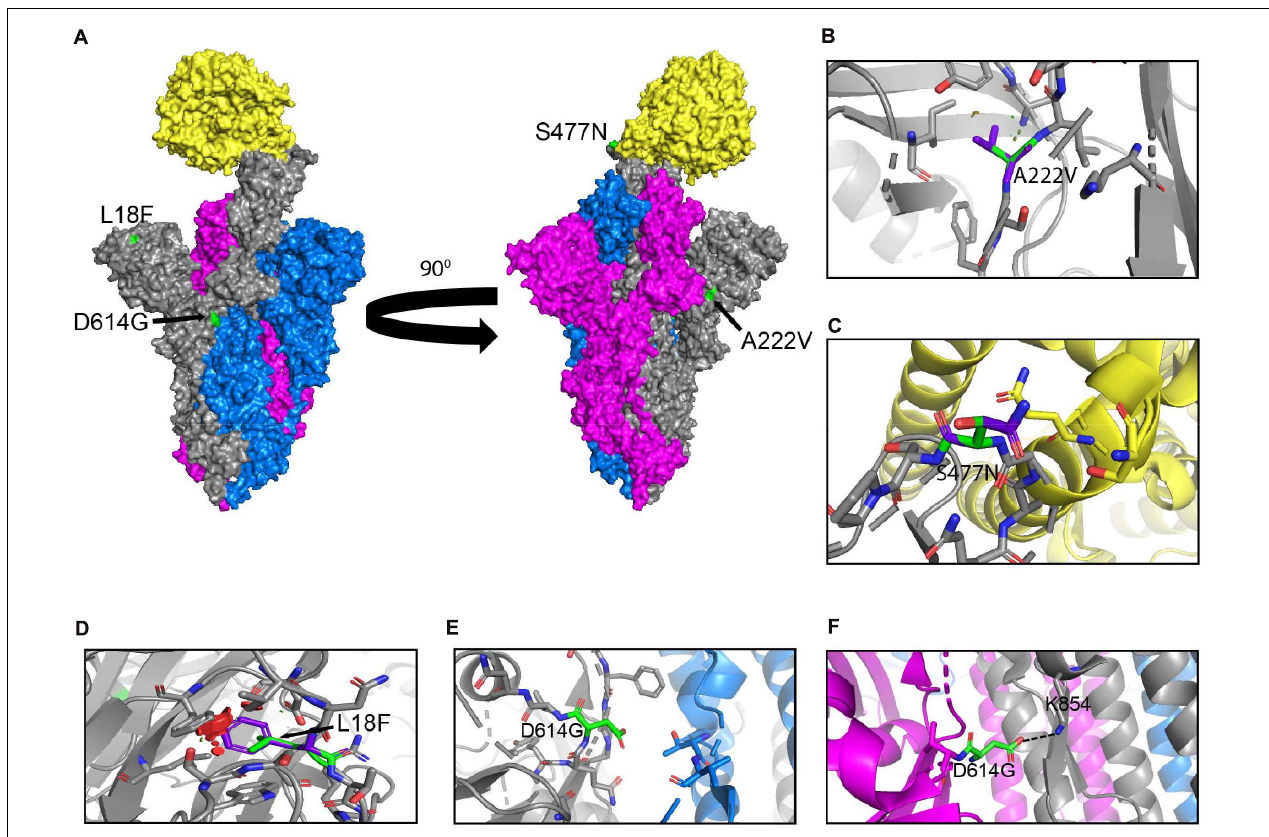
FIGURE 3 | Structural rendering of the most frequent mutations in the S protein. (A) Surface representation of human angiotensin-converting enzyme 2 (hACE2) (yellow) in complex with S protein trimers illustrated in gray, blue, and magenta. Interactions of high frequency mutations are presented as follows: (B) A222V, (C) S477N, (D) L18F, (E) D614G in the open conformation, and (F) D614G in the closed conformation. Reference sequence residues are illustrated in green, and the mutated amino acid is represented in purple. The red markers illustrate the steric clash when the mutations are inserted into the structure. Graphs were generated using PyMOL.